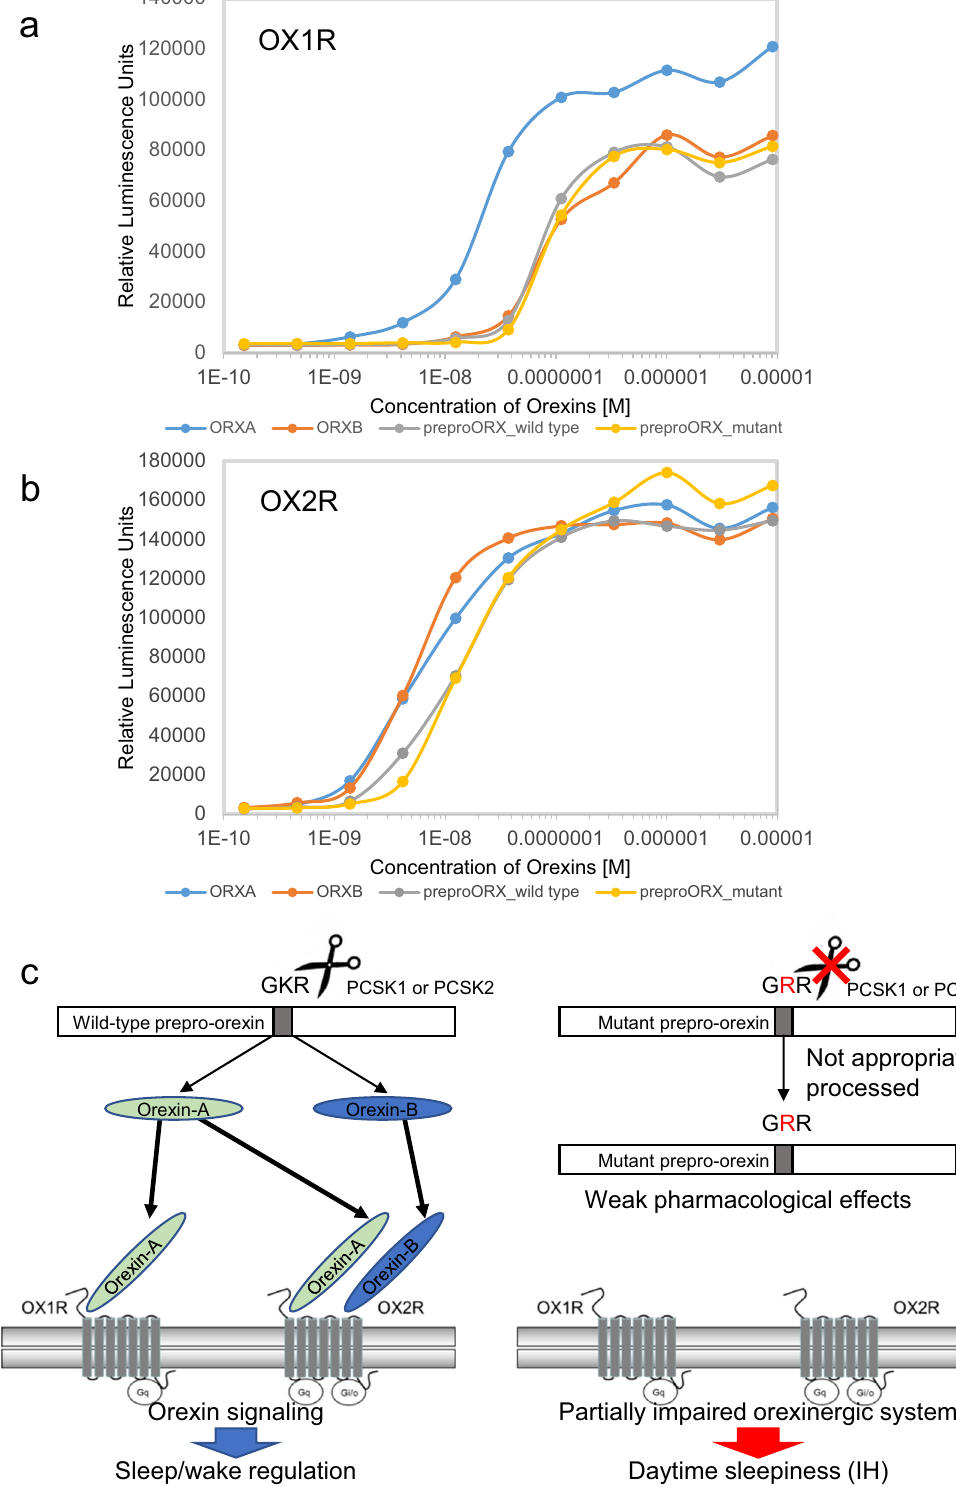
Fig. 2 Pharmacological characterization of orexin peptides on orexin signaling through orexin receptors and schematic representation of orexin receptors. a (OX1R), b (OX2R) The ligand-induced β -arrestin recruitment system was utilized to assess pharmacological effects of human orexin-A (blue), orexin-B (red), full-length wild-type prepro-orexin (gray), and full-length mutant prepro-orexin (yellow). Light emission values were determined in duplicate. Circles on the lines indicate doses of the given peptides. c Orexin-A acts on both OX1R and OX2R, whereas orexin-B mainly acts on OX2R. The mutant form of prepro-orexin exhibited weak pharmacological effects on both OX1R and OX2R. OX1R is coupled exclusively to the Gq subclass of heterotrimeric G proteins, whereas OX2R may couple to Gi/o and/or